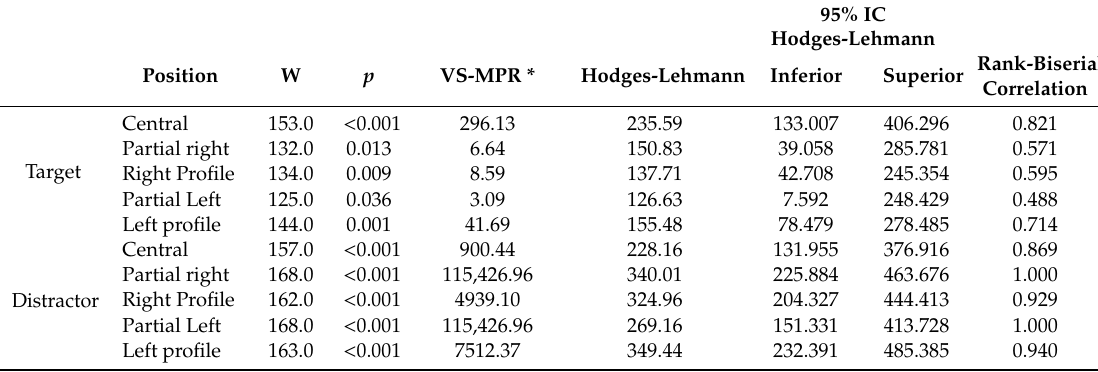
Table 4. Mann–Whitney U test for experimental conditions in the clusters.